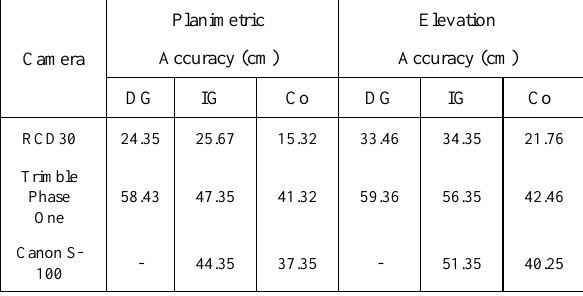
Table 3. ICP Level 1 (DG:Direct Georeferencing, IG:Indirect Georeferencing, Co:Combined DG-IG)